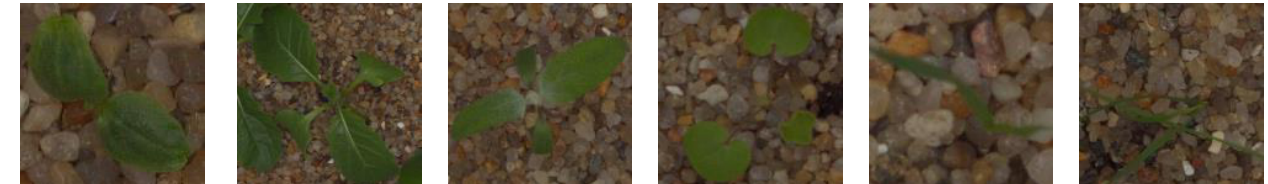
Figure 2. Example images of the 12 species in the PlantSeedlings dataset. The order of species (left to right, top to bottom) corresponds to the labels (from left to right) in Figure 1.